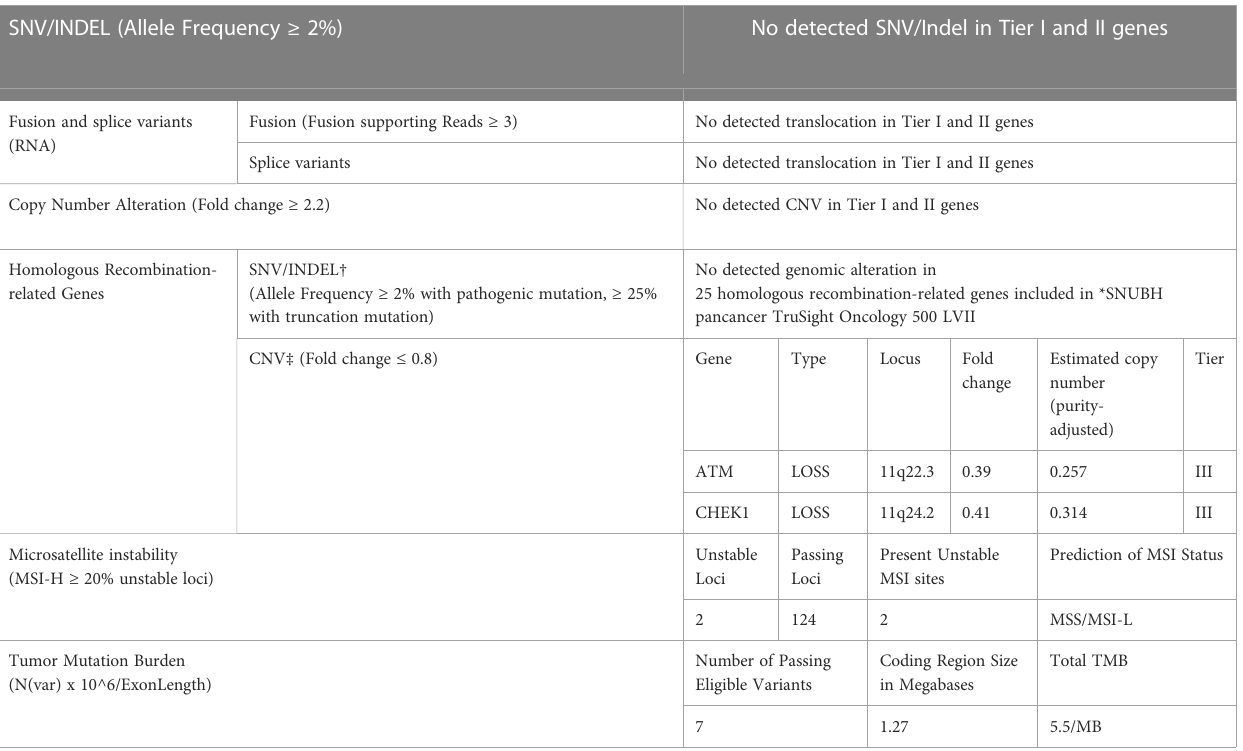
TABLE 1 TruSight Oncology 500 assay result (Tier I and II only). SNV/INDEL (Allele Frequency ≥ 2%) No detected SNV/Indel in Tier I and II genes